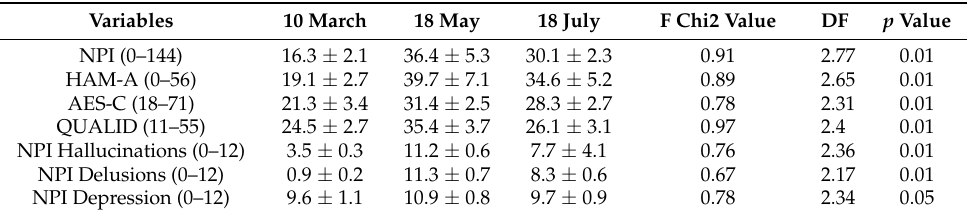
Table 2. Comparison of mean value and SD of the defined neuropsychological scores.